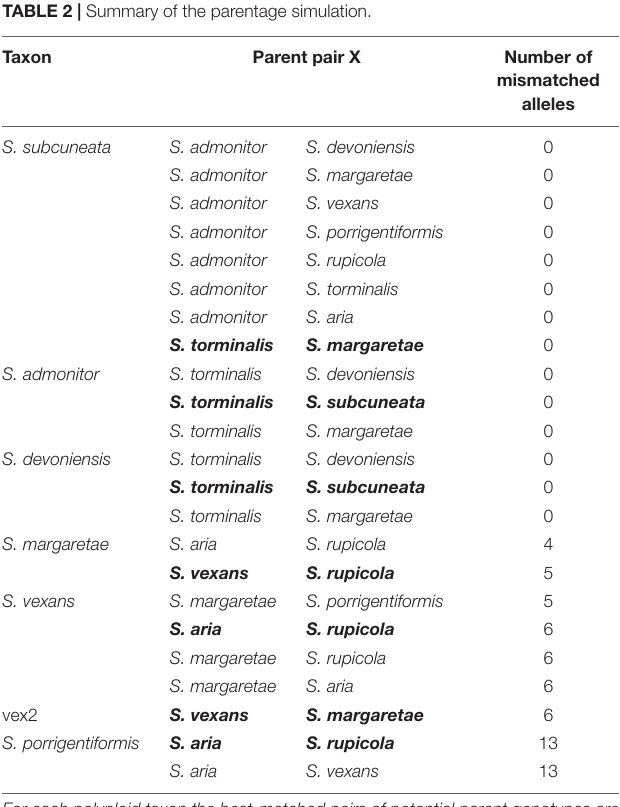
mismatched alleles